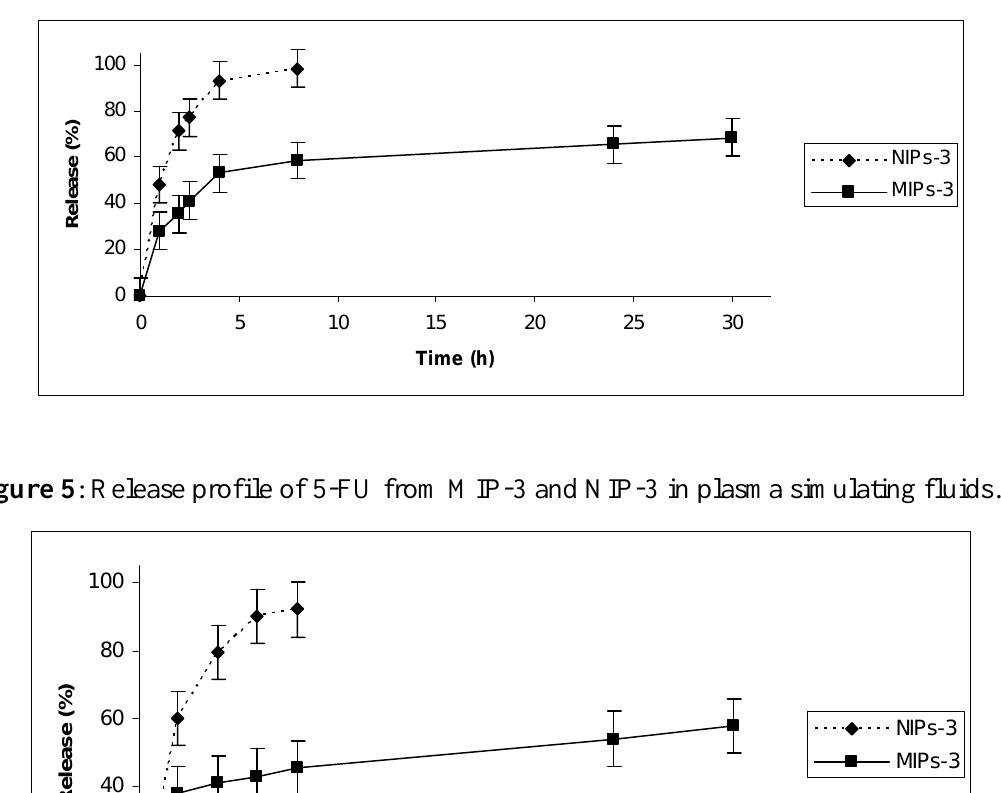
Figure 4 . Release profile of 5-FU from MIP-3 and NIP-3 in gastrointestinal simulating fluids.